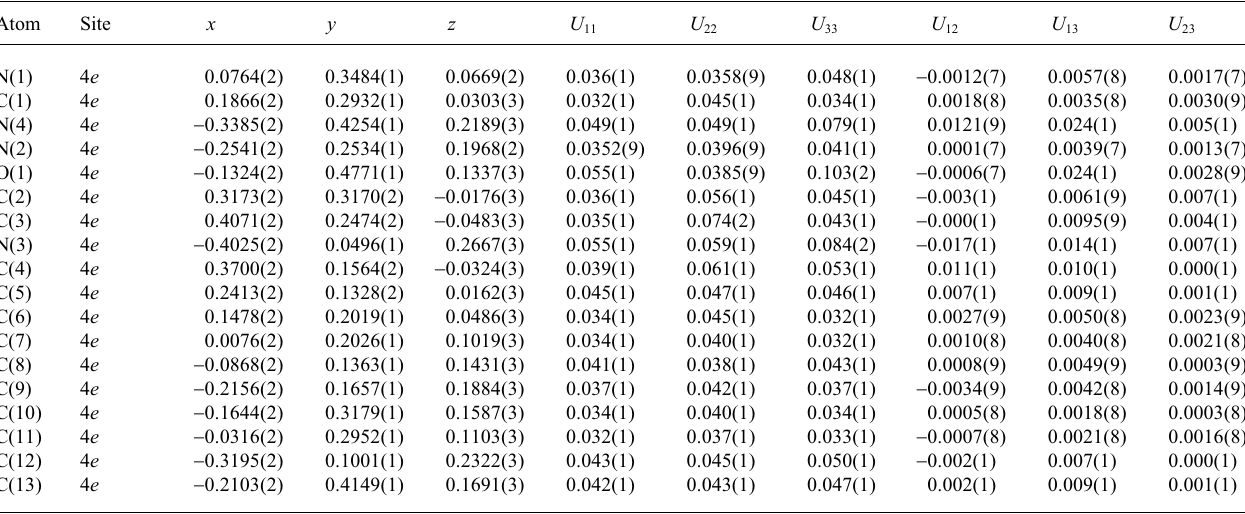
Table 3. Atomic coordinates and displacement parameters (in Å 2 )